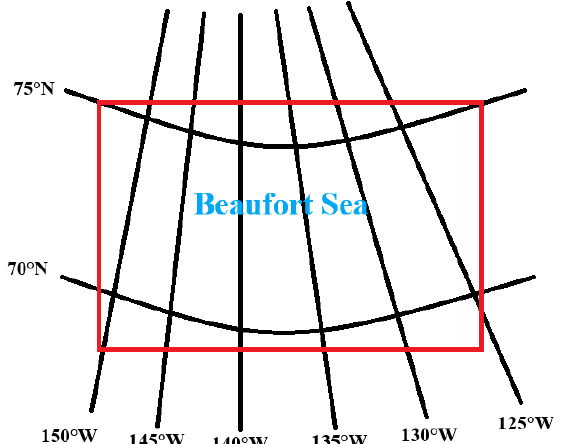
Figure 9. The geographical location of the Beaufort Sea [22].